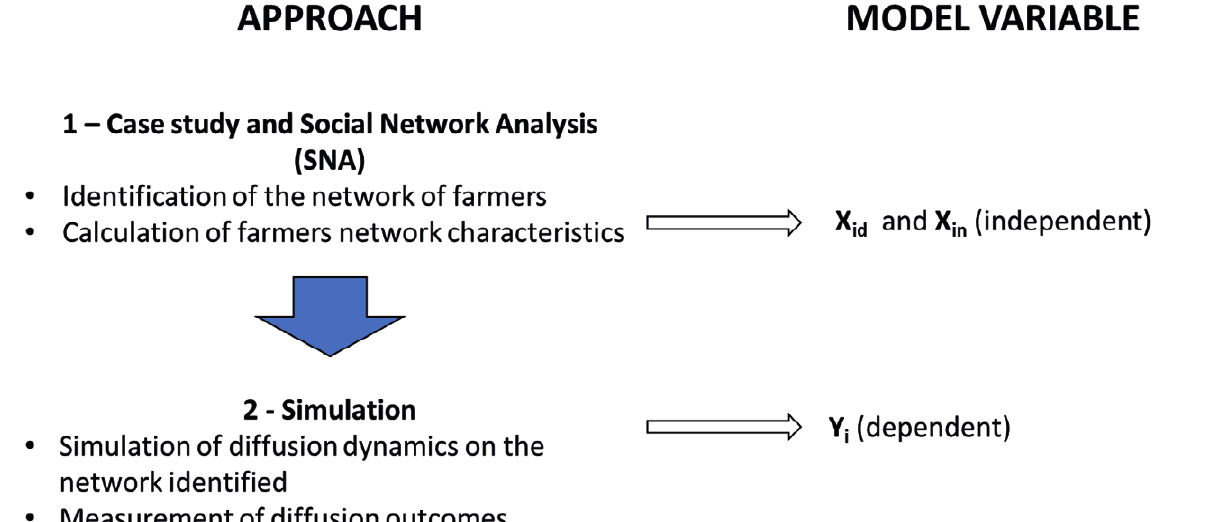
Figure 2. Th e integrated approach. Source: own elaboration.